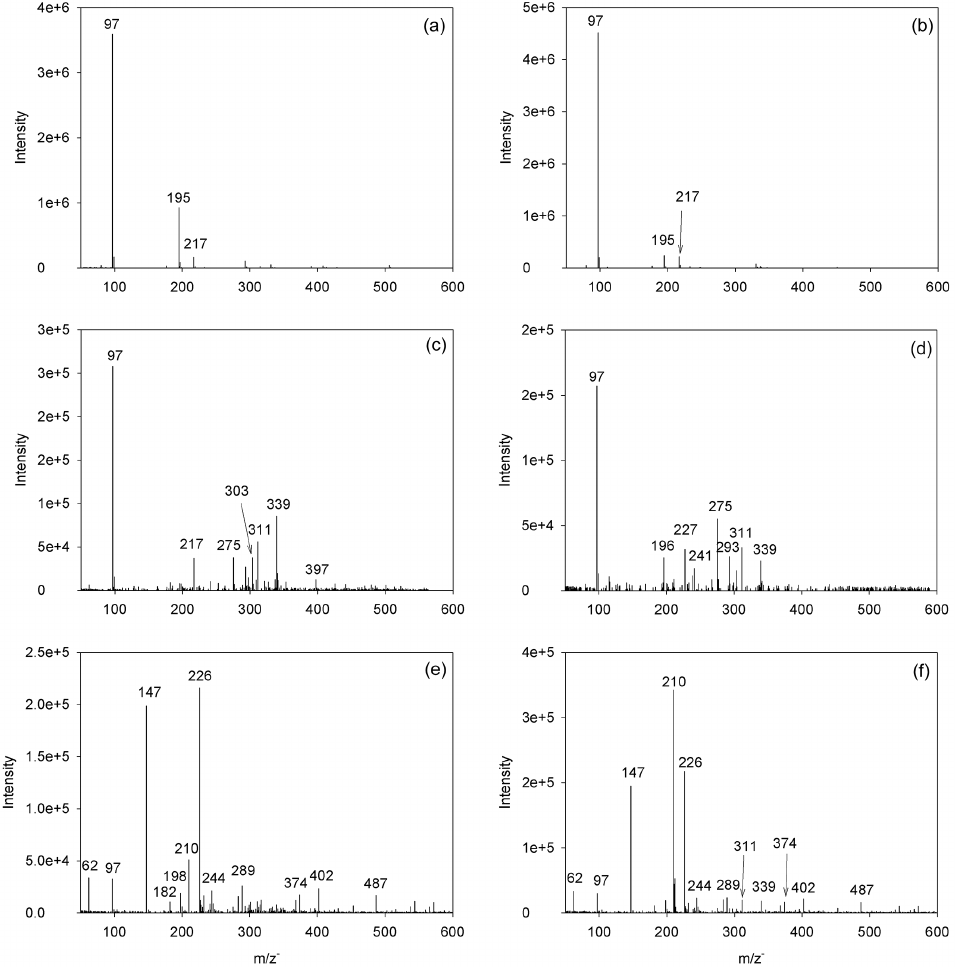
Figure 2. Negative-mode mass spectra for dark reactions of glyoxal–H 2 O 2 –(NH 4 ) 2 SO 4 ( a , c and e ) and glyoxal–H 2 O 2 –H 2 SO 4 ( b , d and f ). Panels (a) and (b) show solutions. Panels (c) and (d) show aerosols in the dry chamber, and panels (e) and (f) are aerosols in the humid chamber at dark reaction time =